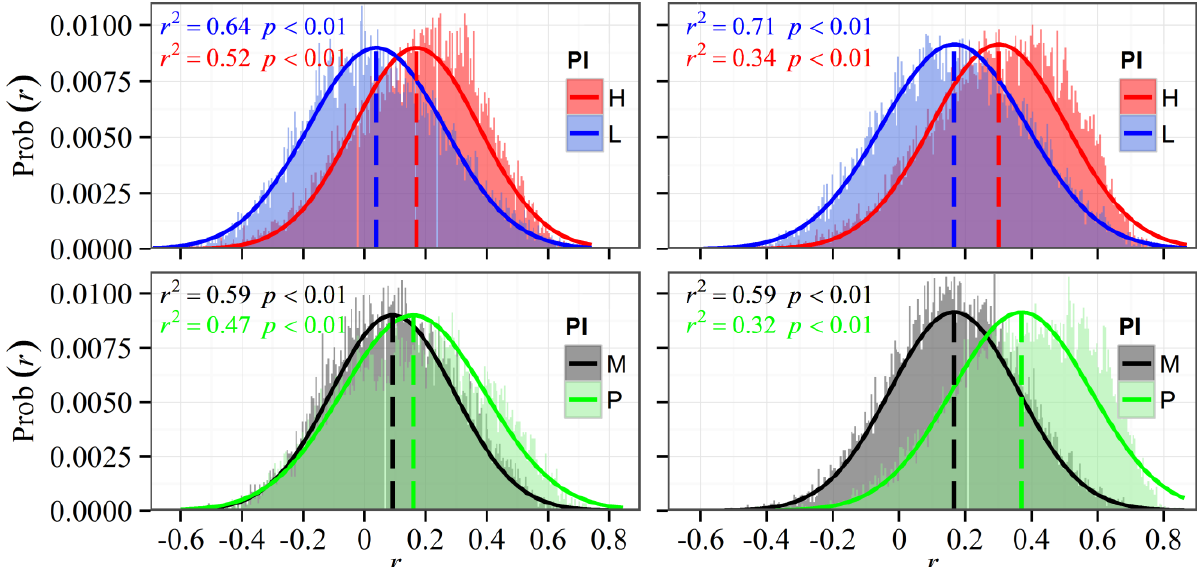
Figure 5. Gaussian probability distributions (Prob( r )) of Pearson correlation coefficient ( r ) between the mean growing season NDVI and different intensities of precipitation (PI) (heavy precipitation, H; light precipitation, L; top panel. Total precipitation, P; moderate precipitation, M; bottom panel). Light, moderate and heavy precipitations were defined as the amount of received precipitation of less than 5.67 mm per day, between 5.67 and 11.33 mm per day, and larger than 11.33 mm per day, respectively, in relatively humid areas (RHA) ( Left ). Light, moderate and heavy precipitations were defined as the amount of received precipitation of less than 4.67 mm per day, between 4.67 and 9.33 mm per day, and larger than 9.33 mm per day, respectively, in relative arid areas (RAA) ( Right ). The red, and blue lines at top panel indicate fitted Gaussian probability distributions curve lines for r between grass NDVI and heavy and light precipitation, respectively; the green and black lines at bottom panel indicate fitted Gaussian probability distributions curve lines for r between grass NDVI and total and moderate precipitation,